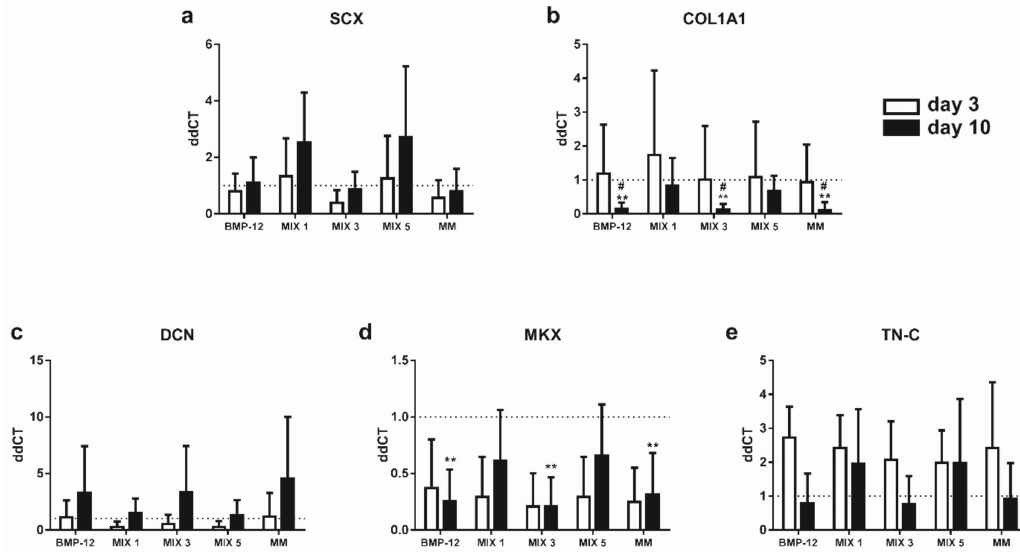
Figure 6. Expression of tendon-specific markers by ASCs at 3 and 10 days after tenogenic induction. Expression levels of ( a ) SCX ; ( b ) COL1A1 ; ( c ) DCN ; ( d ) MKX ; ( e ) TN-C in ASCs after tenogenic induction. Data are expressed as mean ddCT ± SD normalized to YWHAZ and CTRL sample. n = 7. ** p < 0.01 vs. CTRL. # p < 0.05 vs. MIX